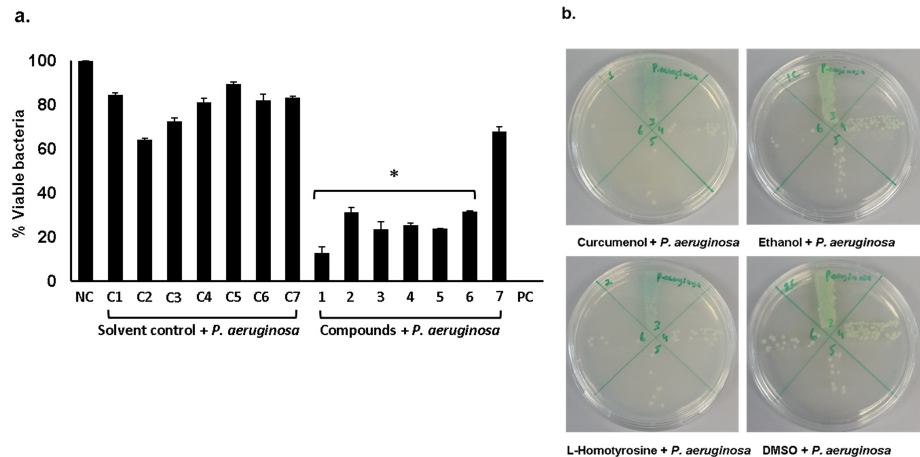
Figure 1. Antibacterial assays of pure compounds against P. aeruginosa. Briefly, 50 µg/mL of each